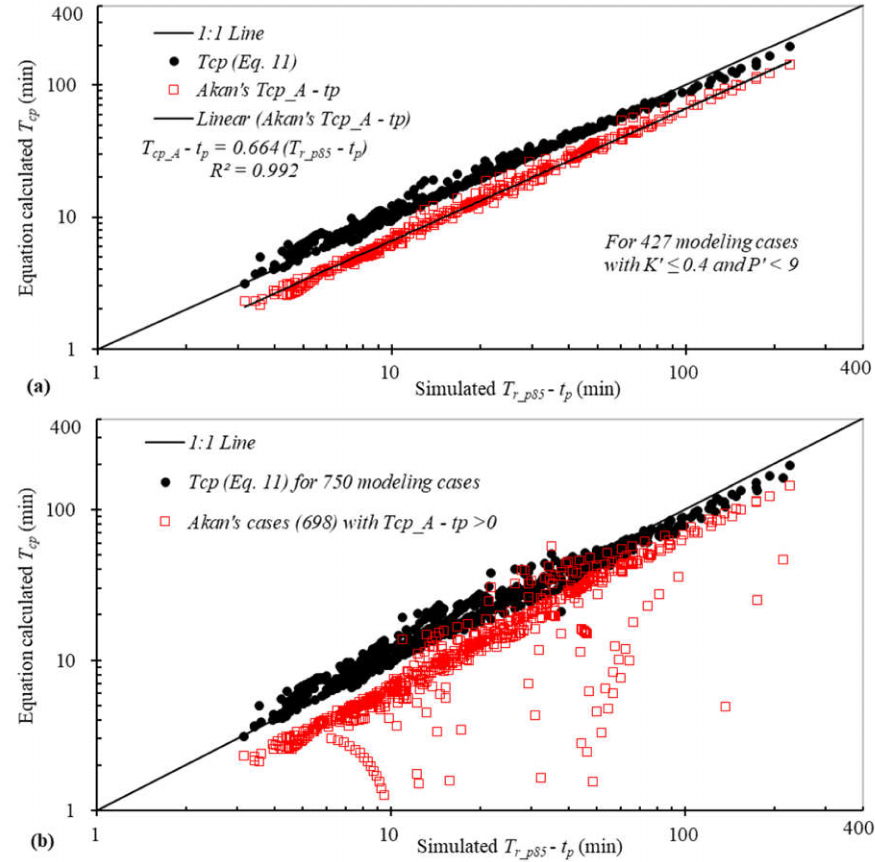
Figure 8. Comparison of equation calculated T cp and T r_p85 − t p : ( a ) 427 modeling cases with K (cid:48) ≤ 0.4 and P (cid:48) < 9 cases, ( b ) 750 modeling cases for Equation (11) and 698 modeling cases with Akan’s T cp − t p >